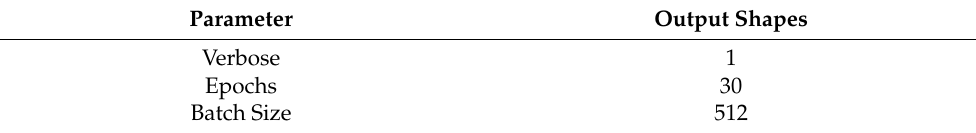
Table 7. Hyperparameter.